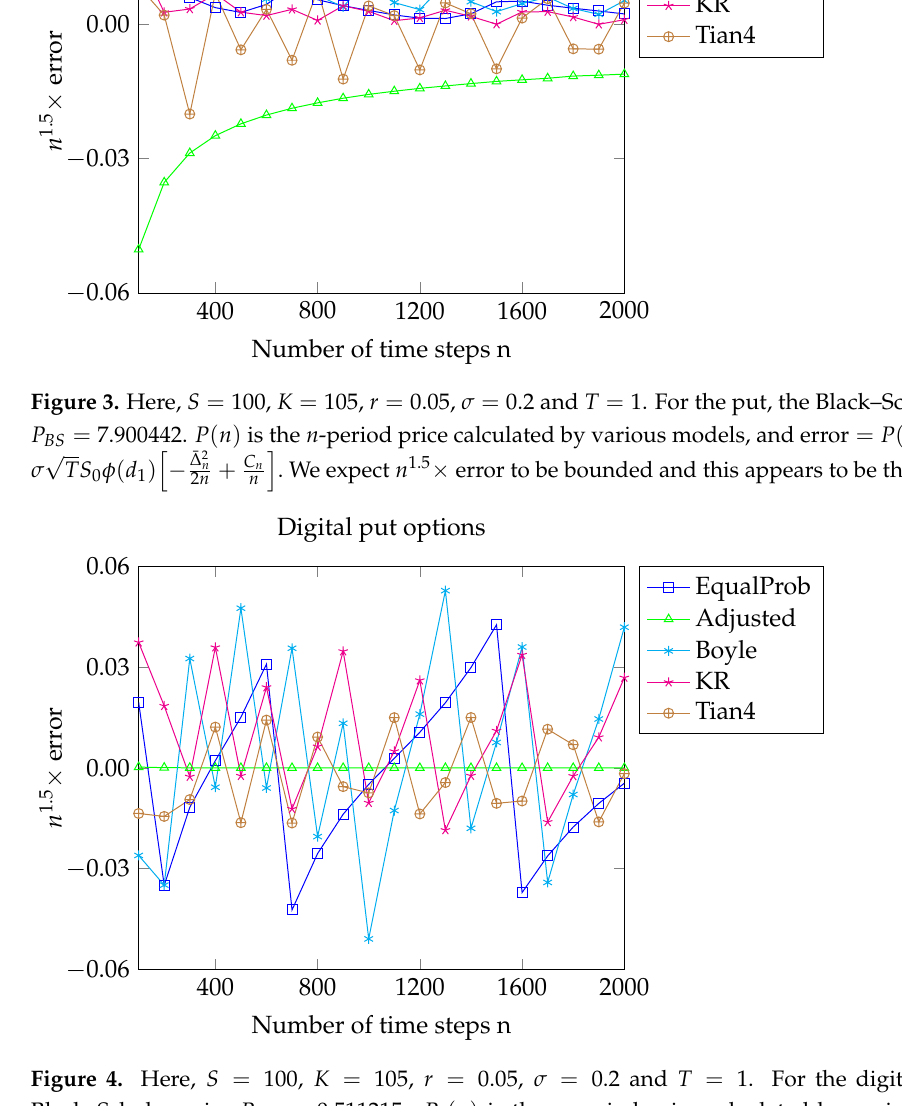
(cid:104) ¯ ∆ (cid:105) + d 2 ¯ ∆ 2 n − B n n √ . We expect n 1.5 × error to be bounded and n 2 n n